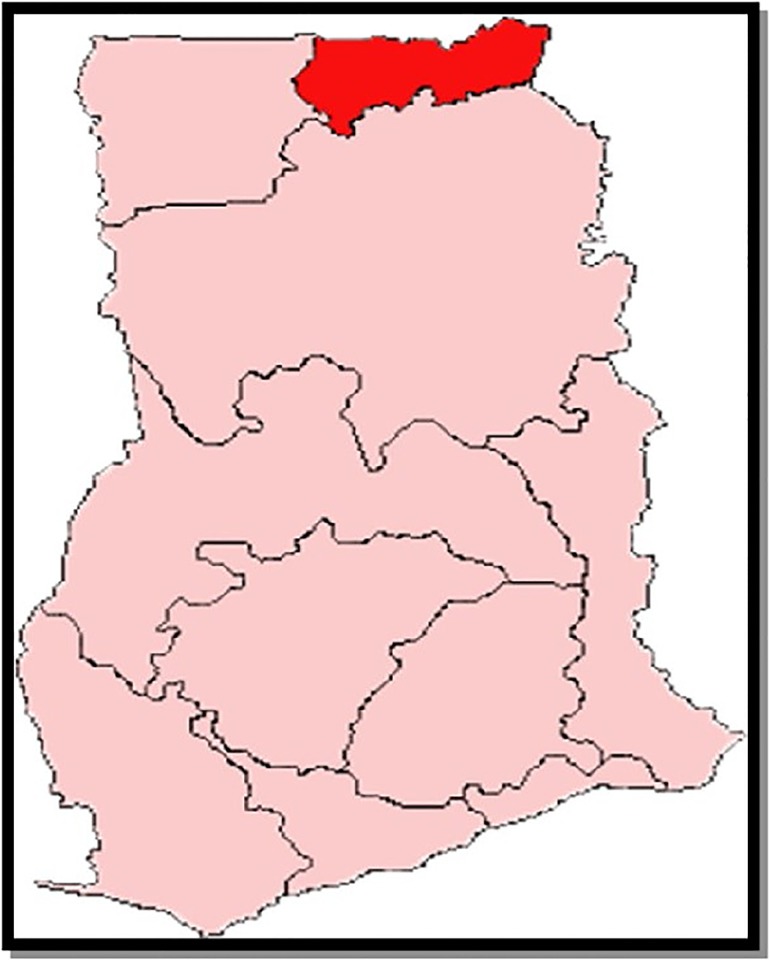
Map of Ghana showing Upper East region in red.